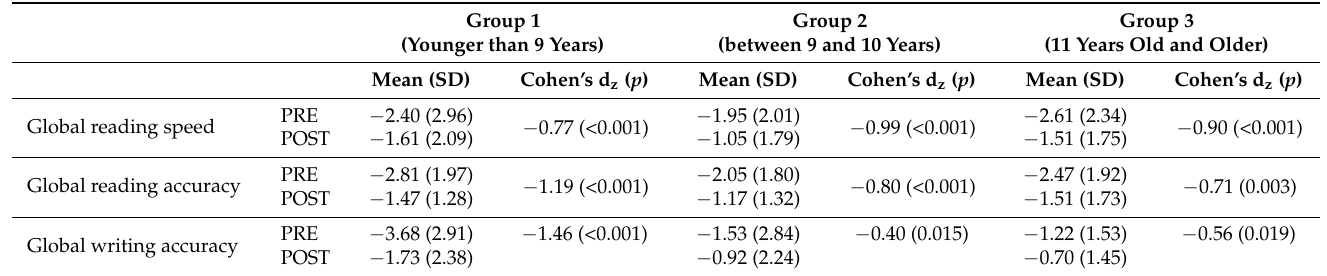
Table 1. Mean scores (SD in parentheses) and effect sizes (Cohen’s d z ) of the three age